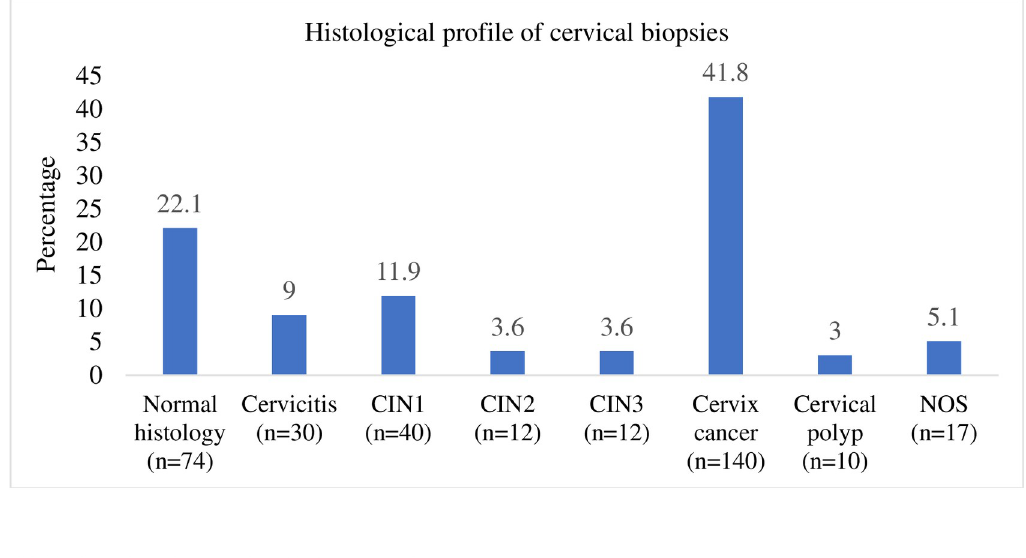
Fig 1. Percentage distribution of cervical biopsy histology